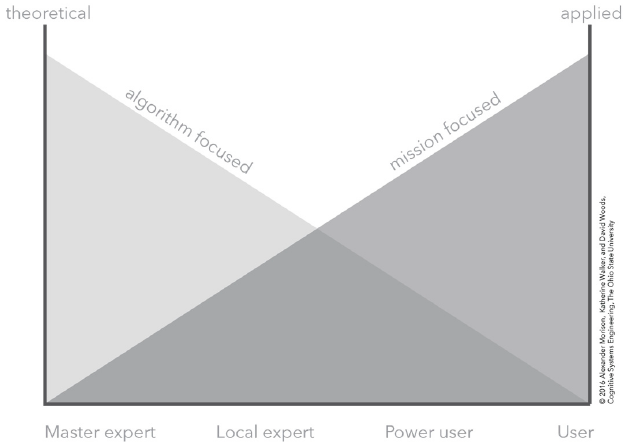
Figure 1. A conceptual depiction of the relationship between a theoretical or applied understanding of the human–computation–sensor system and the knowledge, expertise, and experience of an analyst.